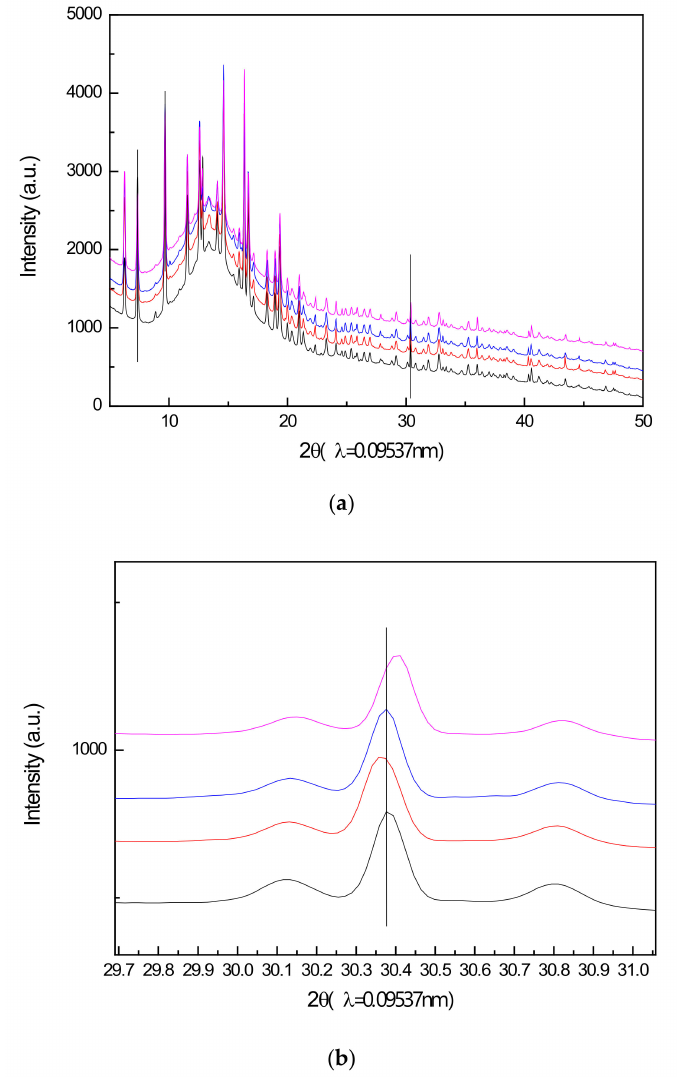
Figure 5. ( a ) Powder X-ray spectra of V f (black), V r350 (orange), V r400 (blue), and V r450 (pink). ( b ) Magni- fied powder X-ray spectra (29.7 < θ < 31.1) of V f (black), V r350 (orange), V r400 (blue), and V r450 (pink).